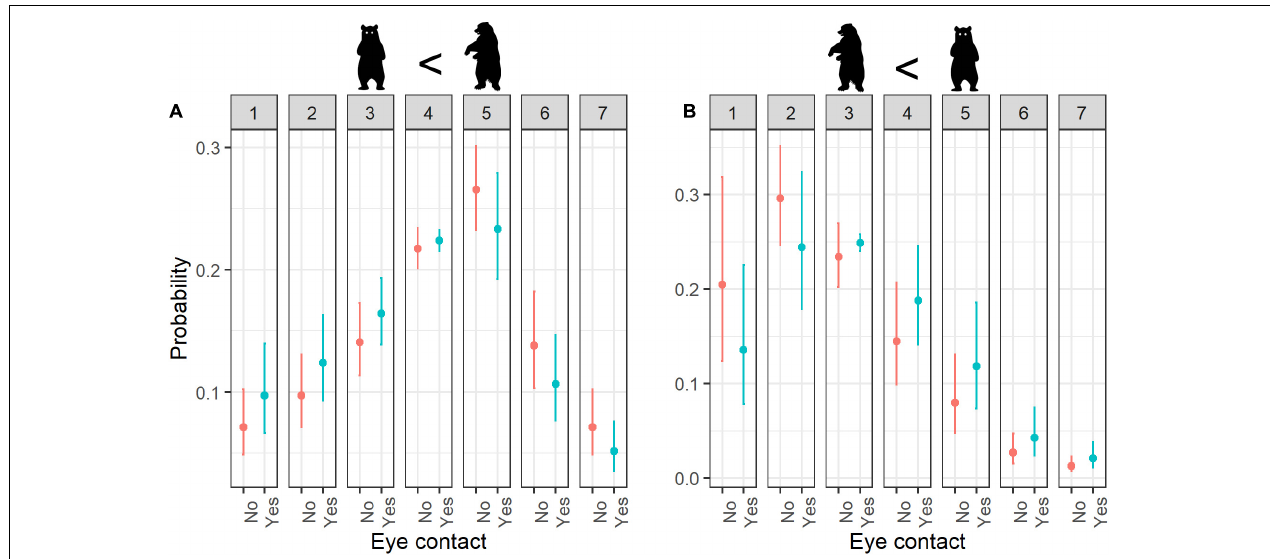
FIGURE 7 | Estimated probability of ratings for (A) cuteness and (B) fear according to Eye contact. Error bars indicate 95% confidence interval; numbers 1–7 refer to rating scores.